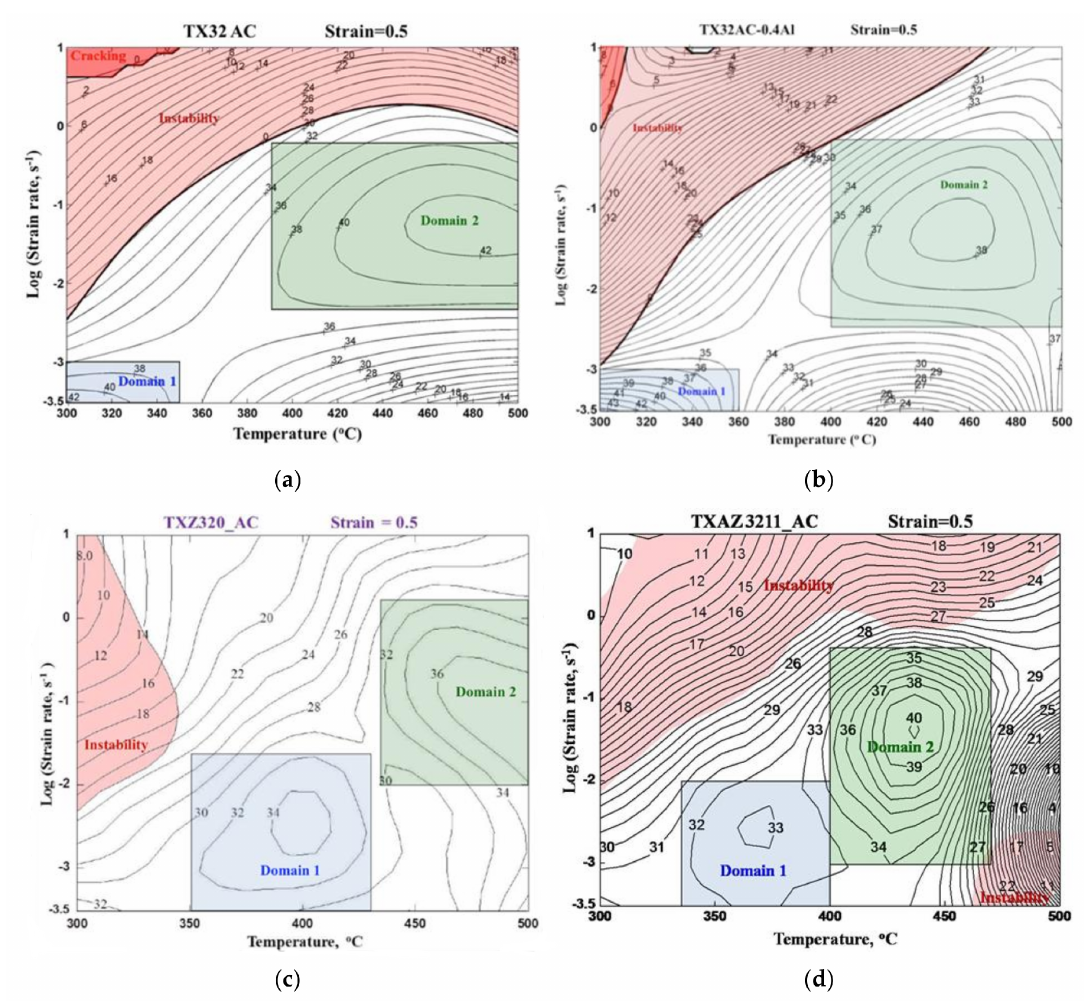
Figure 14. Processing maps for ( a ) TX32 [17]; ( b ) TX32-0.4Al [18]; ( c ) TX32-0.4Zn; and ( d ) TX32-1Al-1Zn alloys at a true strain of 0.5. The numbers on the contours represent power dissipation efficiency in percent. The flow instability regimes are